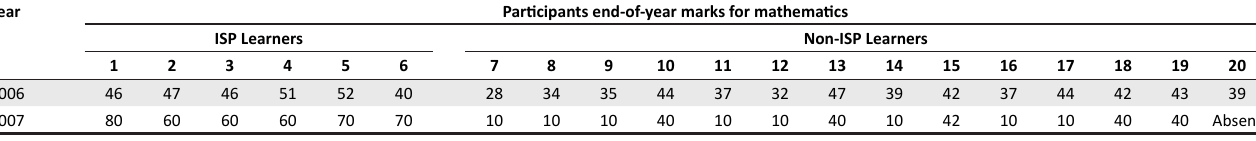
TABLE 5: Case study – Grade 11 and Grade 12 end-of-year marks for mathematics.